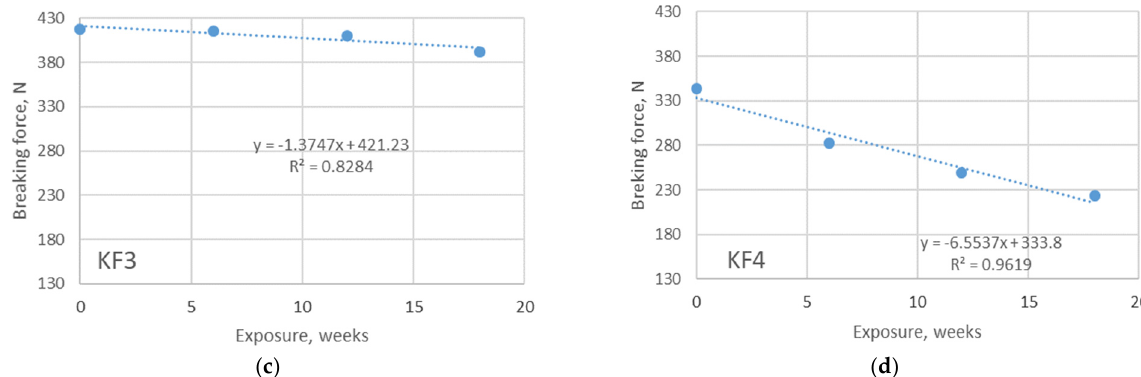
Figure 6. Breaking force of materials exposed to aging in pool water, indoors. The overview is given for: ( a ) material KF1; ( b ) material KF2; ( c ) material KF3; ( d ) material KF4.